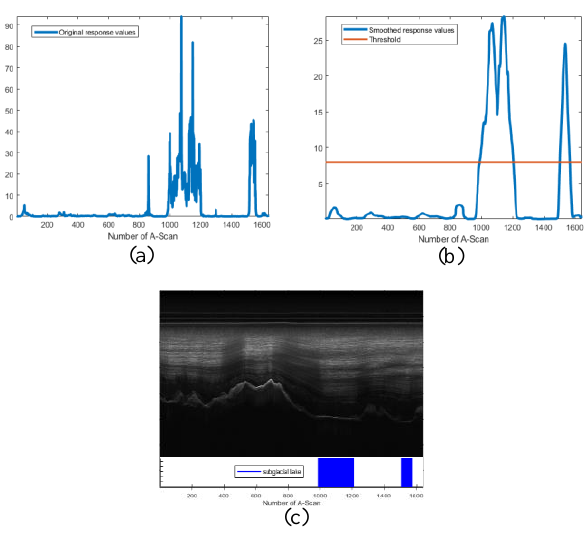
Figure 5 . Experimental results. (a) original response value for subglacial lakes, (b) smoothed response value for subglacial lakes and corresponding threshold, (c) subglacial lakes extraction